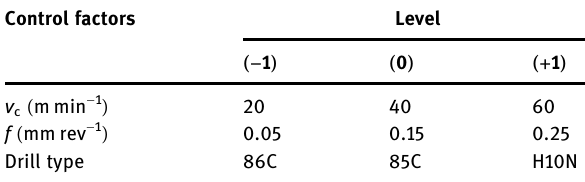
Table 3: Three levels of input parameters Control factors